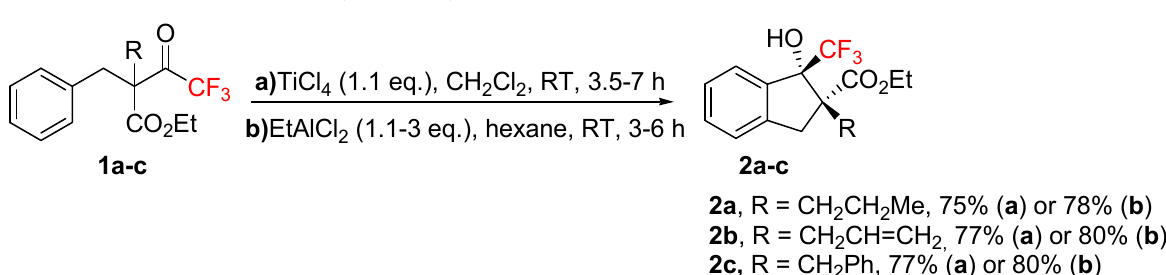
Scheme 1. TiCl 4 or EtAlCl 2 -induced stereoselective synthesis of 1-CF 3 -indanes 2a-c from CF 3 - β -keto esters 1a-c .